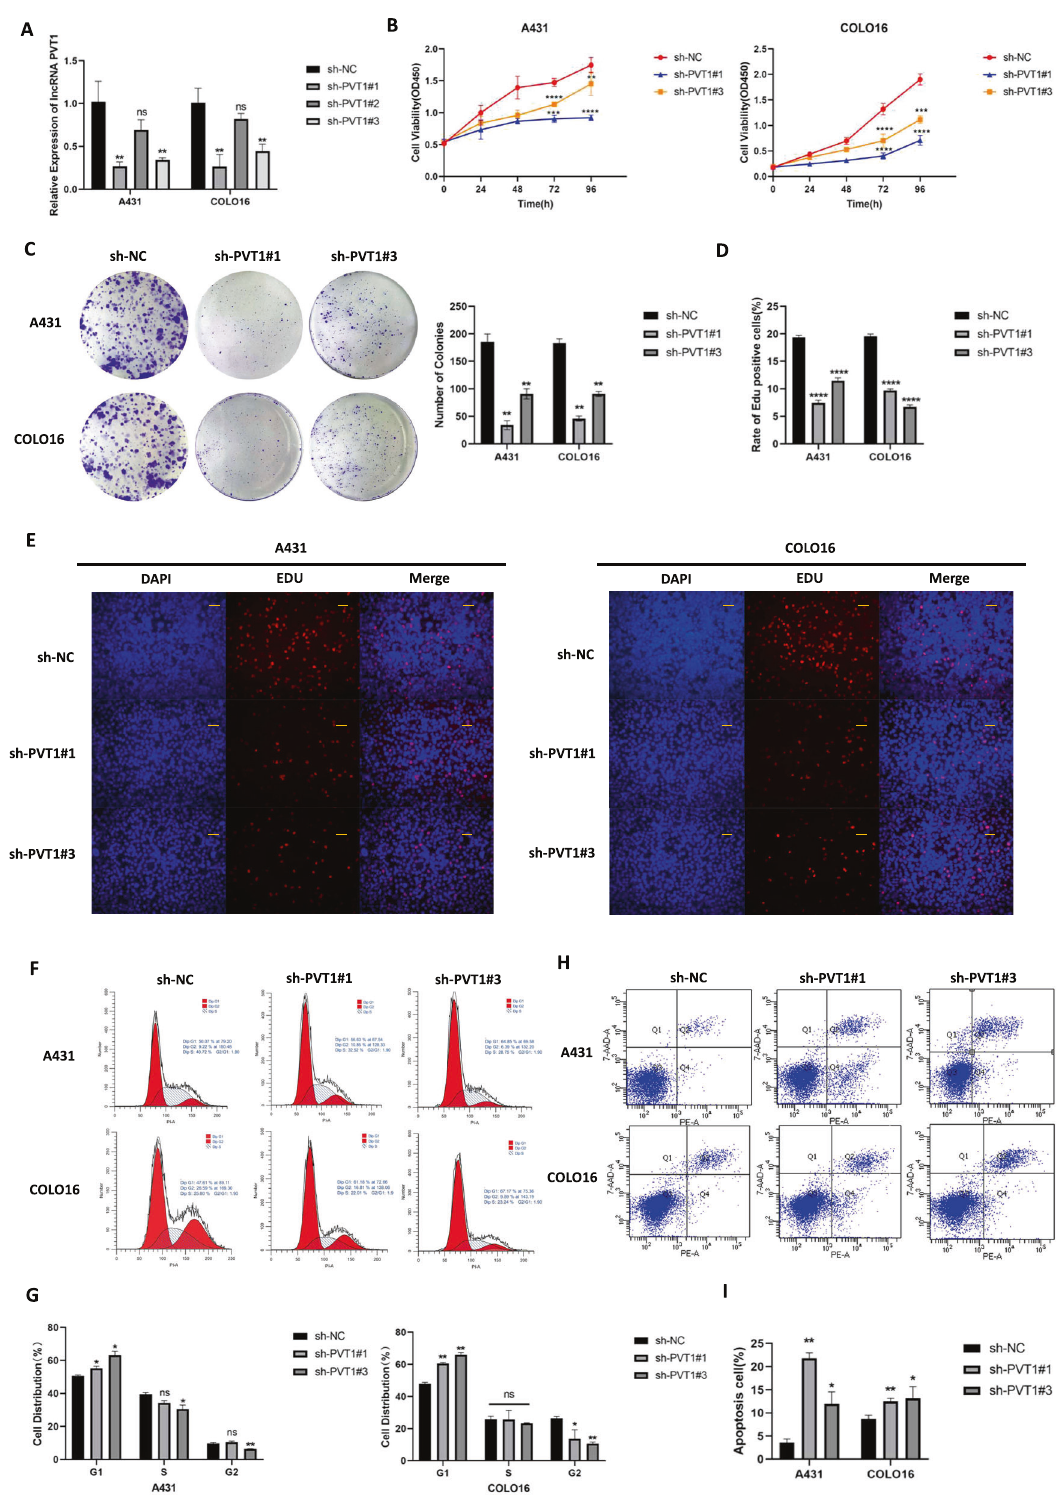
Fig. 2 LncRNA PVT1 knockdown regulates the viability and apoptosis of A431 and COLO16 cells in vitro. A The ef fi ciency of PVT1 knockdown in A431 and COLO16 cells was validated by RT-qPCR. Cell proliferation and quanti fi cation in vitro were detected by CCK-8 assay ( B ), colony formation ( C ), and EDU assay (200×magni fi cation, scale bar = 50 µm) ( D , E ). Flow cytometry was performed to quantify cell cycle ( F , G ) and cell apoptosis ( H , I ) in A431 and COLO16 cells. * P < 0.05, ** P < 0.01, *** P < 0.001, **** P < 0.0001. ns no statistical signi fi cance.